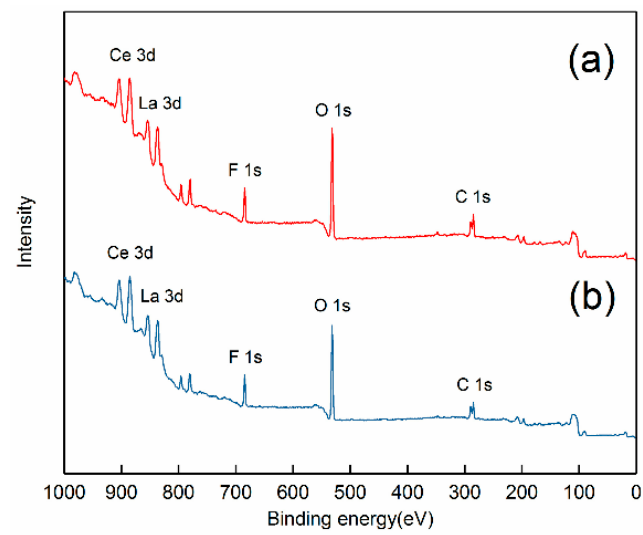
Figure 5. XPS survey spectra of ( a ) untreated bastnaesite, ( b ) bastnaesite treated with strontium ions.